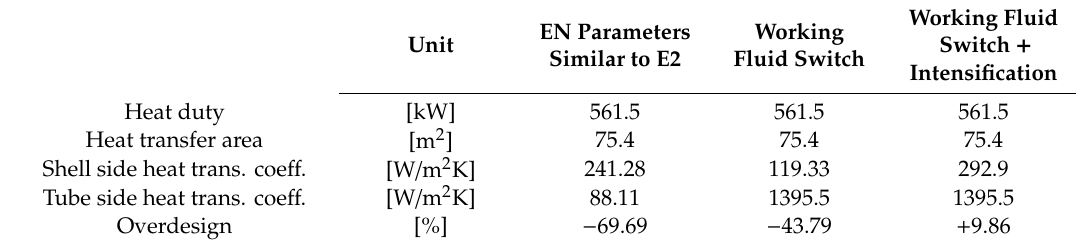
Table 5. The EN heat exchanger rating development in the DD stage.